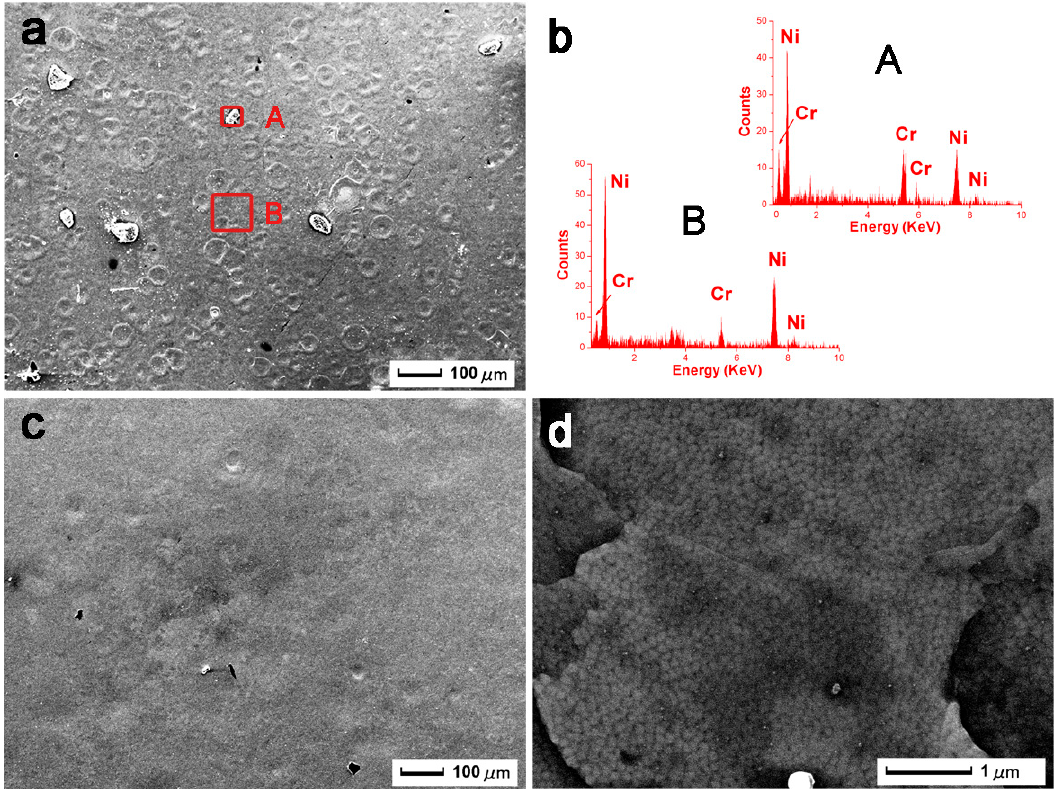
Figure 2. The SEM images of HCPEB Cr-Ni irradiated samples ( a ) 10 pulses, ( b ) energy dispersive spectrum analysis, ( c , d ) 20 pulses.